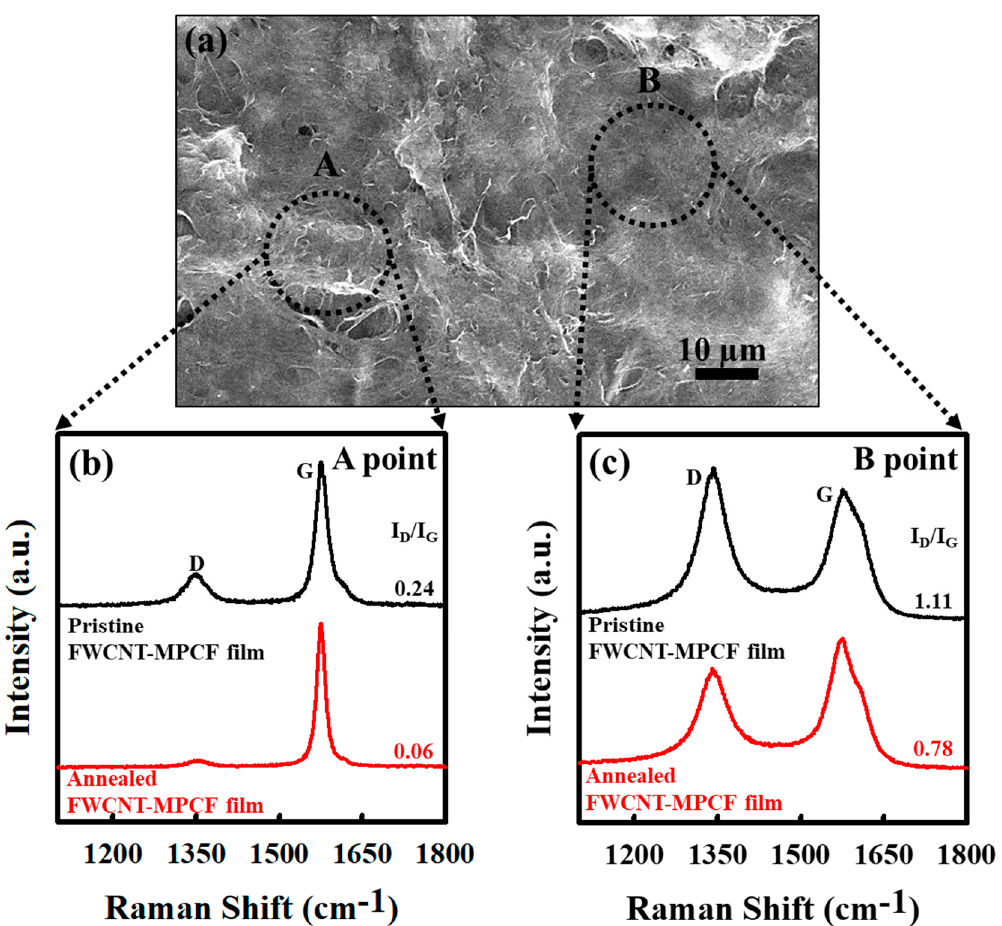
Figure 5. ( a ) HR-SEM images of FWCNT-MPCF hybrid film with MPCF (length: 200 µ m) content of 60 wt % (ultrasonication for 0.5 h); ( b ) and ( c ) Raman spectra at points “A” and “B” of FWCNT-MPCF hybrid film with MPCF content of 60 wt % (ultrasonication for 0.5 h) before and after thermal annealing at 1000 °C . The D -band (approximately 1350 cm − 1 ) and G-band (approximately 1580 cm − 1 ) are related to defect-induced structural disorders and sp 2 carbons, respectively.